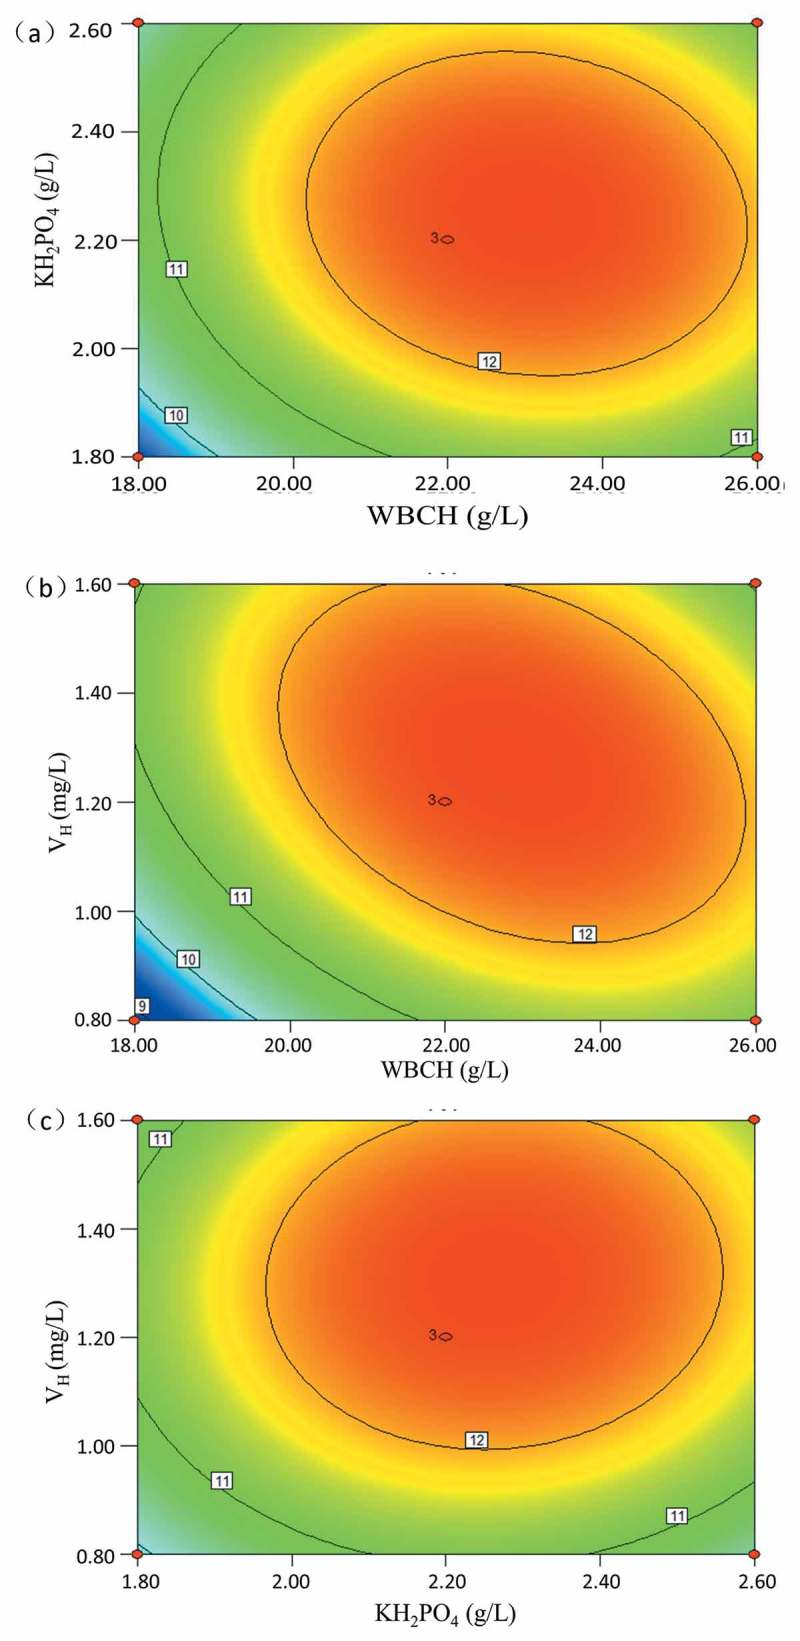
Combined effect of (a) WBCH and KH2PO4 concentration; (b) WBCH and VH concentration; (c) KH2PO4 and VH concentration on L-tryptophan production.